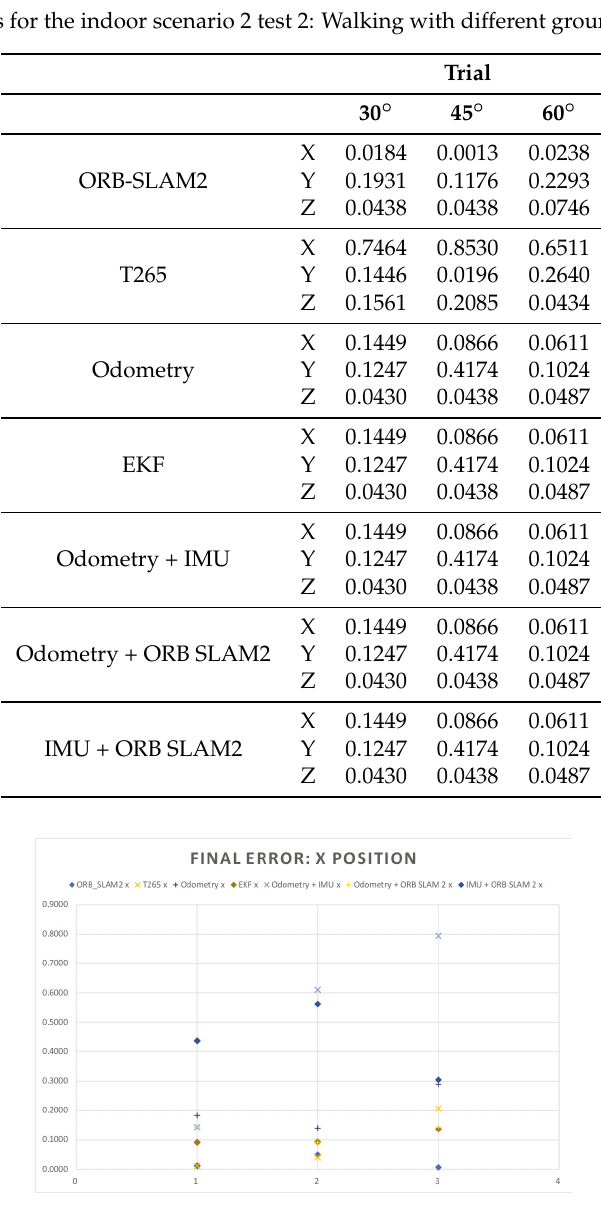
Figure 22. Indoor tests scenario 2. Test 1. Trials 1–5. Final error X position.